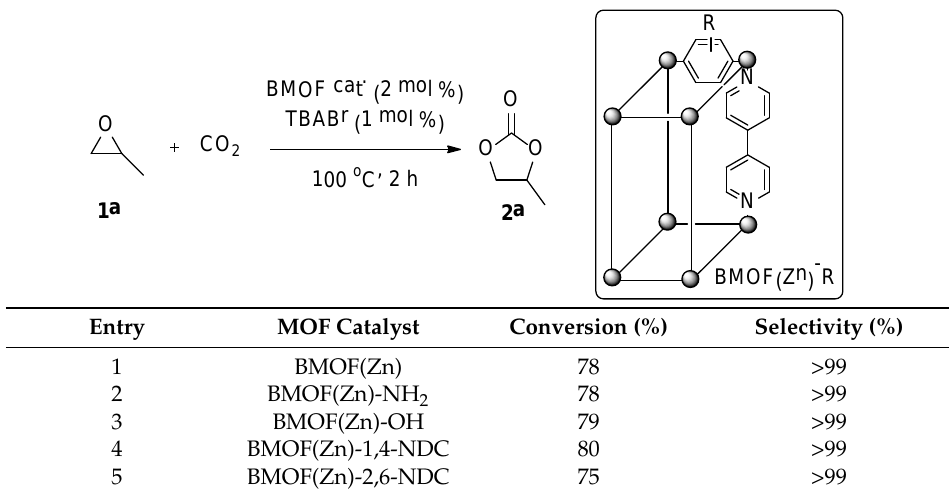
Table 3. Functional group controls in BMOF(Zn)s.